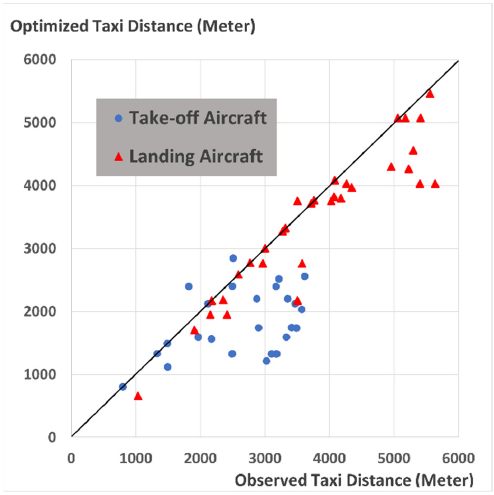
Figure 10. Result comparison of total taxi distance with runway reselection. Table 2. Decreasing rate of total taxi distance.